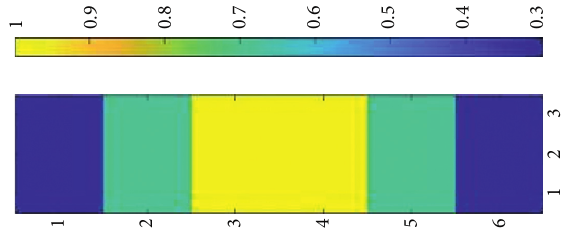
Figure 5: The current distribution of the array elements after applying the Chebyshev tapering